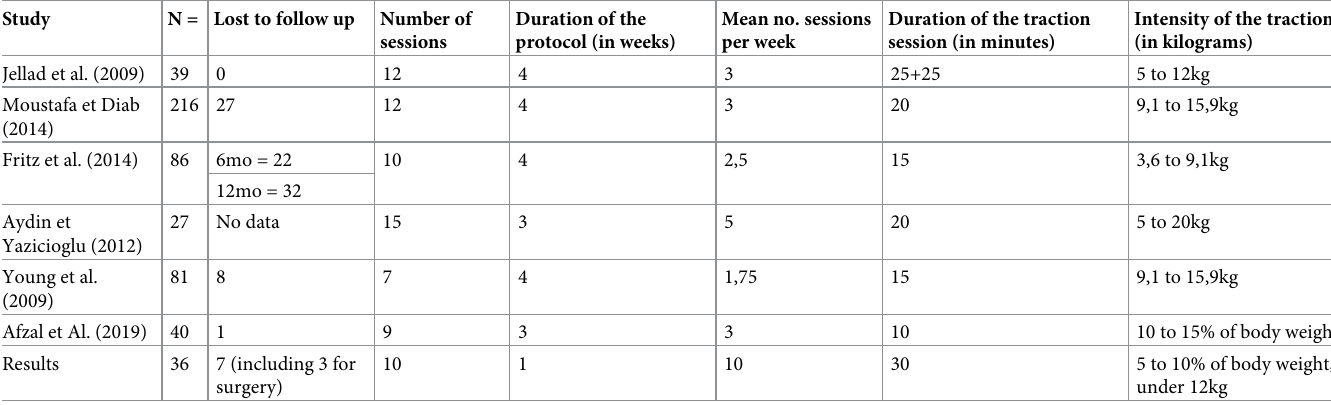
Table 3. Comparison of protocol conditions across